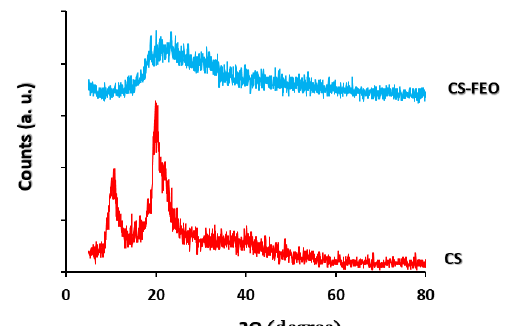
Fig.2: X-ray Diffraction patterns of the pure CS and CS-FEO nanocomposite Fig. 2. X-ray Diffraction patterns of the pure CS and CS-FEO nanocomposite.